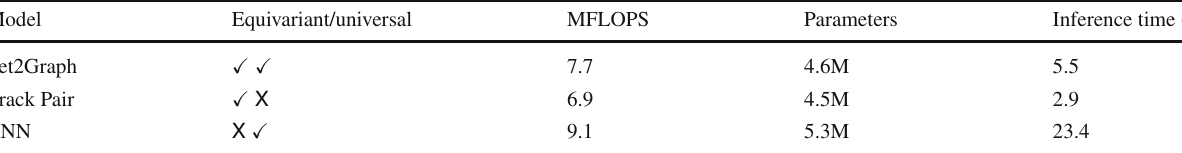
Table 1 Comparison of the neural network models. The inference time and FLOPS are measured per single jet with 14 tracks. FLOPS were estimated with [36] Model